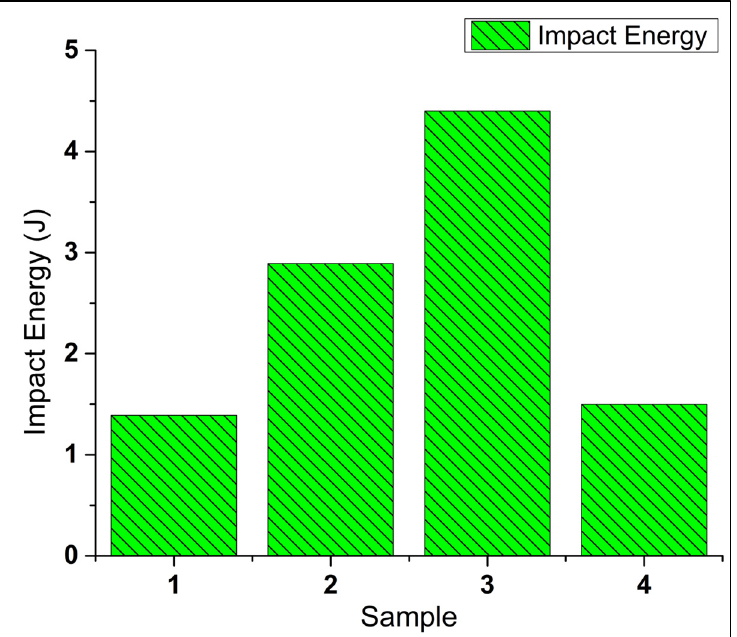
Figure 12. Average Impact Energy of: AA7075 (base alloy, sample 1), AA7075-5wt %SiC (MMC, sample 2), AA7075-5wt %SiC-3wt %RHA (s-HMMC, sample 3), and AA7075-5wt %SiC-3wt %RHA- 1wt %CES (n-HMMC, sample 4).